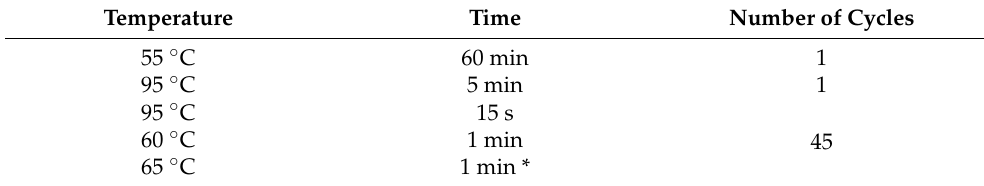
Table 3. qRT-PCR run